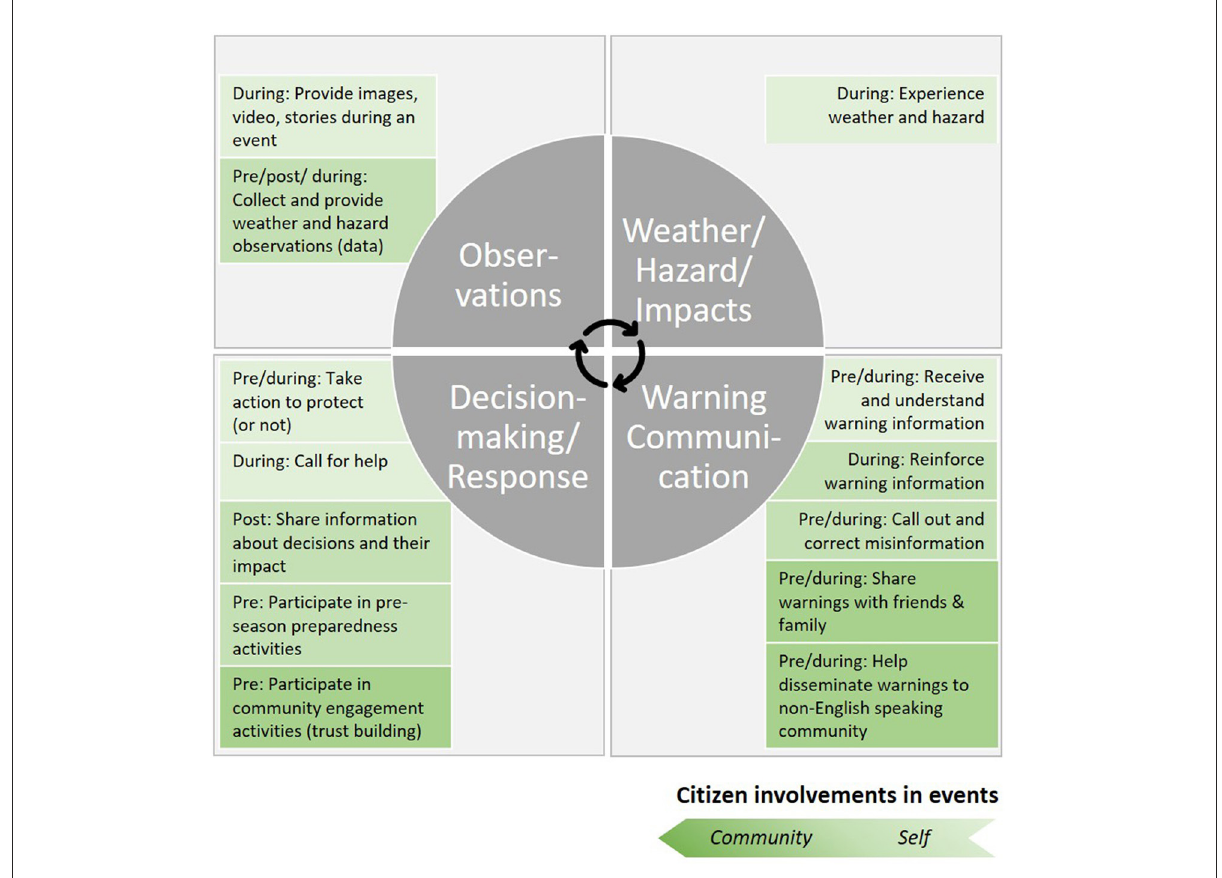
FIGURE4 A visual summary of findings on citizens’ involvement in the warning value